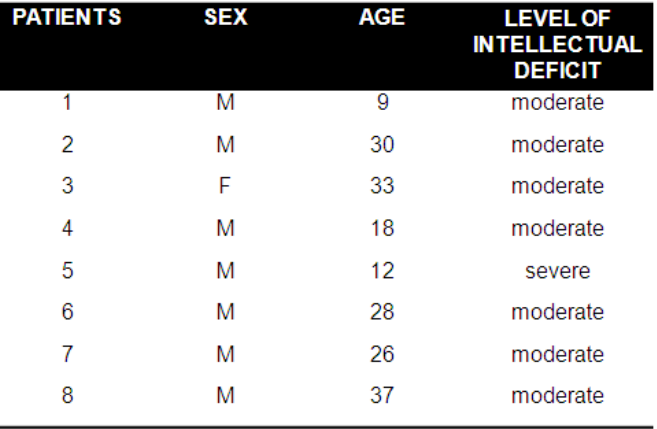
Table 2- Data from Down’S syndrome patients without periodontal disease